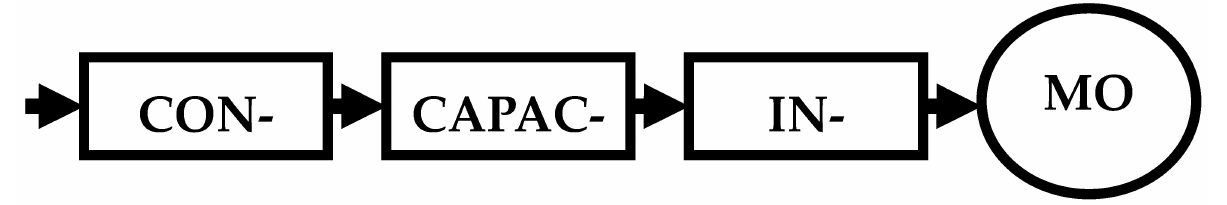
Figure 1. Basic block diagram of a